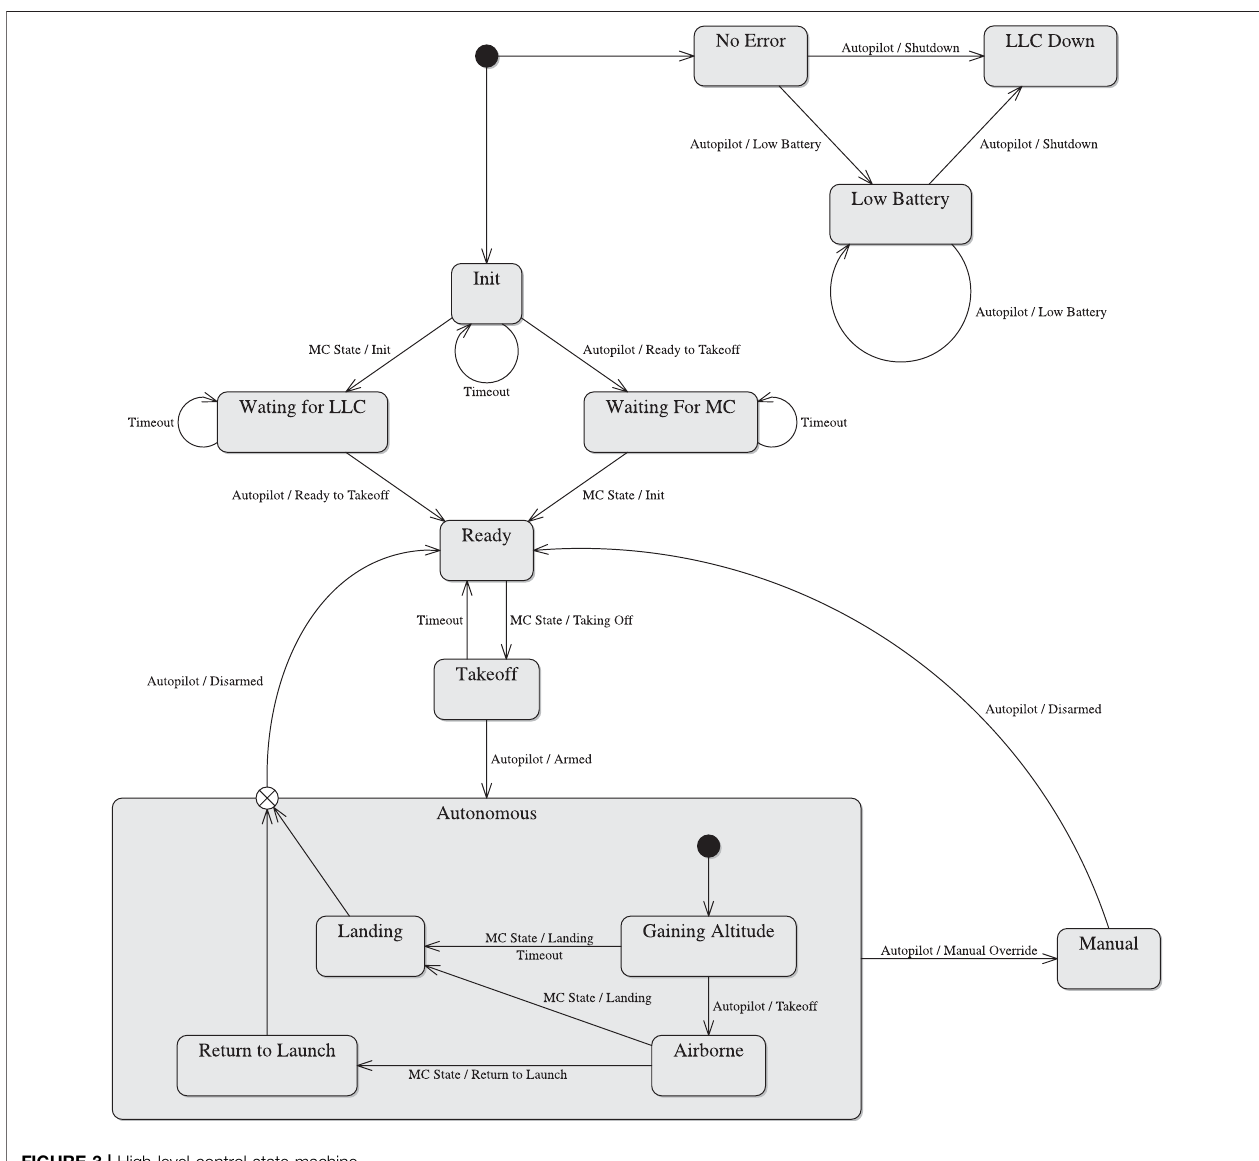
FIGURE 3 | High-level control state